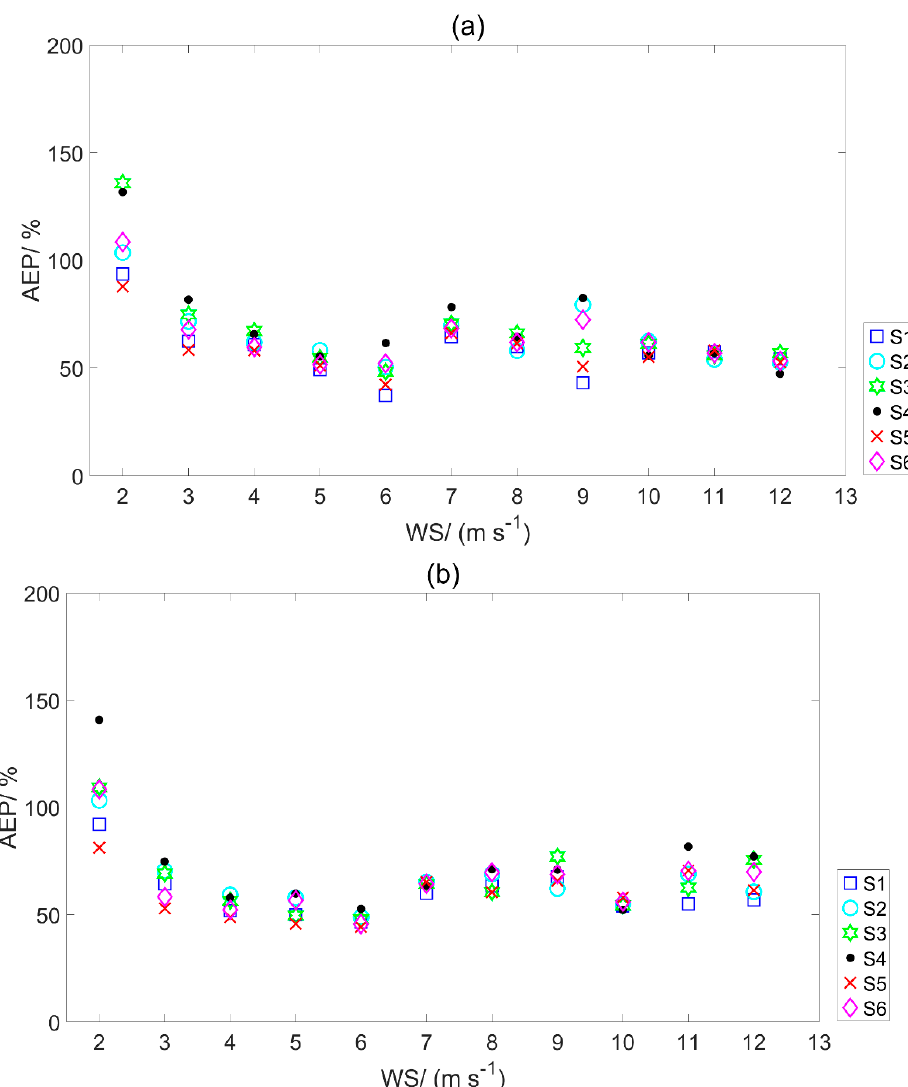
Figure 4. Same as Figure 3, but for Hongliuhe station.Simulation result with ( a ) the global forecast system (GFS), and ( b ) the ERA5.